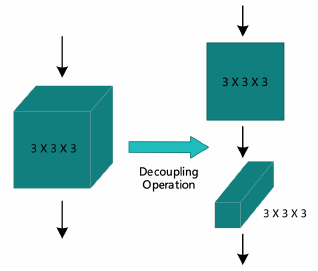
Figure 5. Decoupling 3D convolution